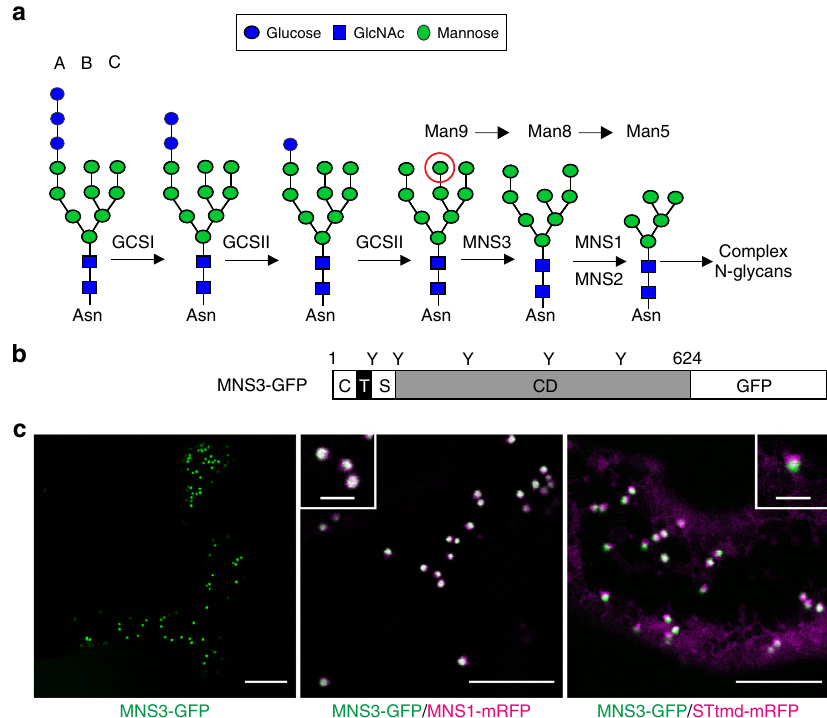
Fig. 1 Arabidopsis MNS3 is a Golgi-resident protein. a The early steps of N-glycan processing in A . thaliana are shown. The three branches of the N-linked Glc 3 Man 9 GlcNAc 2 oligosaccharide precursor are marked A, B, and C. The red circle indicates the terminal α 1,2-linked mannose residue that is cleaved off by MNS3 from the B-branch. GCSI: α -glucosidase I; GCSII: α -glucosidase II; MNS3: ER- α -mannosidase I; MNS1/MNS2: Golgi- α -mannosidase I. b Illustration of the domain organization of MNS3. C, cytoplasmic tail (41 aa); T, predicted transmembrane domain (26 aa); S, stem region (42 aa); CD, catalytic domain (515 aa). Positions of putative N-glycosylation sites are indicated (Y). The depicted numbers represent the length of the protein (624 amino acids). c Subcellular localization of MNS3. Confocal images show N . benthamiana leaf epidermal cells transiently expressing MNS3-GFP (green) alone (scale bar = 20 µ m) and in combination with the cis /medial-Golgi protein MNS1-mRFP (magenta, scale bar = 5 µ m) or the medial/ trans -Golgi marker STtmd-mRFP (magenta, scale bar = 5 µ m). The insets show a higher magni fi cation of individual dual-colored Golgi stacks (scale bar = 2 µ m). Images were